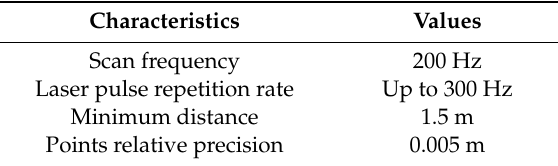
Figure 12. Resulting ballast top ( blue ) and bottom ( green ) extracted lines. Table 1. Riegl VQ-250 sensor main